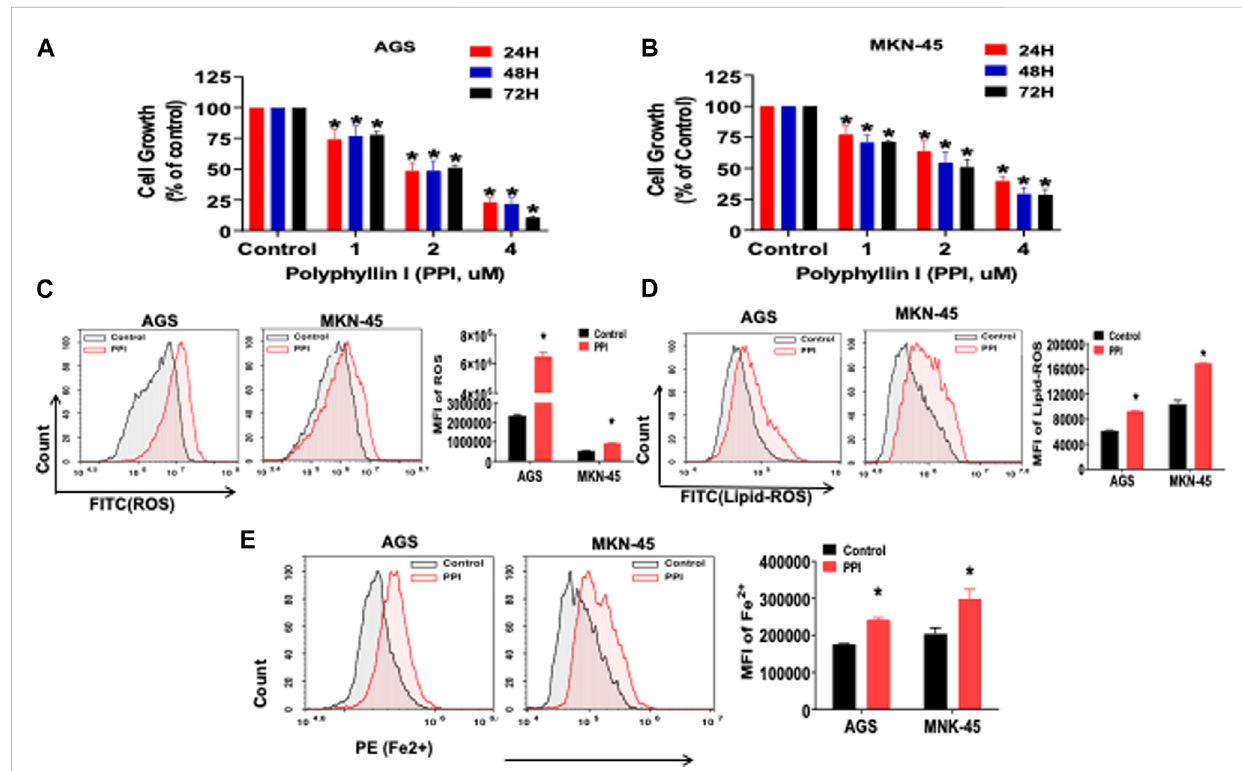
FIGURE 2 PPI suppresses cell growth and induces ferroptosis in the gastric cancer cells. (A, B) The cell growth (expansion) of AGS and MKN-45 cells after treatment with PPI (0, 1, 2, 3, 4 μ M, for 24, 48 and 72 h, respectively) was examined using MTT assays. (C, D) The levels of cellular ROS and lipid peroxides (lipid-ROS) after the treatment with PPI (3 μ M) for 24 h in AGS and MKN-45 cells were analyzed using a fl ow cytometer. (E) The levels of intracellular ferrous ions(Fe 2+ )inAGSandMKN-45 cells afterPPI treatment for 24hwerequanti fi edusinga fl owcytometer.Dataare shownas mean±SD while p values were determined using one-way ANOVA ( *p <